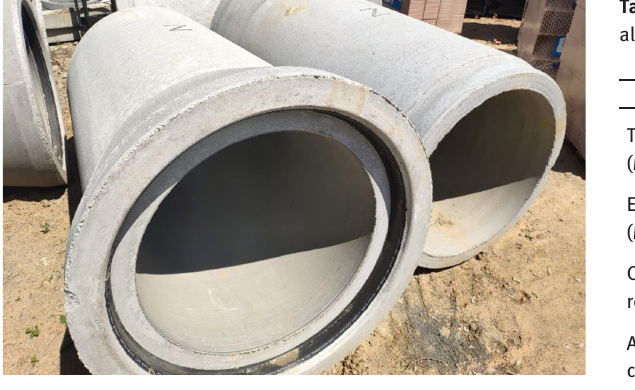
Figure 2: Concrete pipe on a construction site.